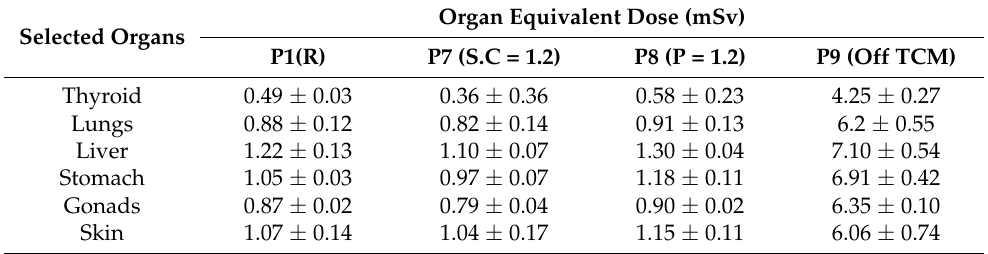
Table 4. A comparison of all objective image quality parameter values acquired in different CT CAP protocols. Image Quality